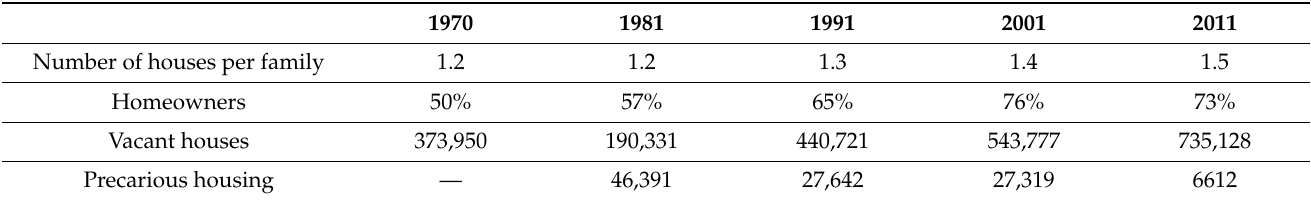
Table 2. Key housing indicators in Portugal